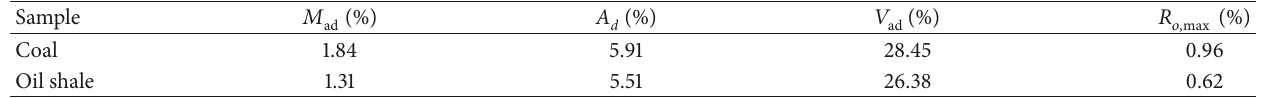
Table 1: Basic properties of the coal and oil shale samples.